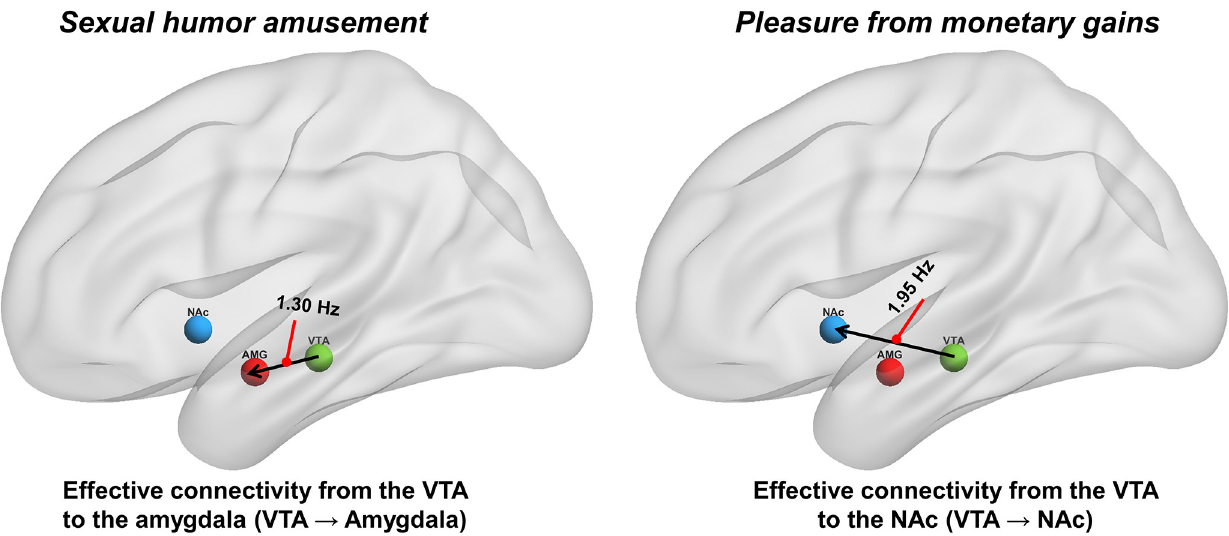
Fig 2. Effective connectivity in processing the consumption of sexual humor and monetary rewards with hedonic ratings as covariates during the outcome phase in the VTA, amygdala, and NAc. (Left) Sexual humor appreciation was associated with modulatory changes (connection strength = 1.30 Hz) in the effectivity connectivity from the VTA to the amygdala (VTA ! amygdala). (Right) Experiencing pleasure from monetary gains was associated with modulatory changes (connection strength = 1.95 Hz) in the effectivity connectivity from the VTA to the NAc (VTA ! NAc).